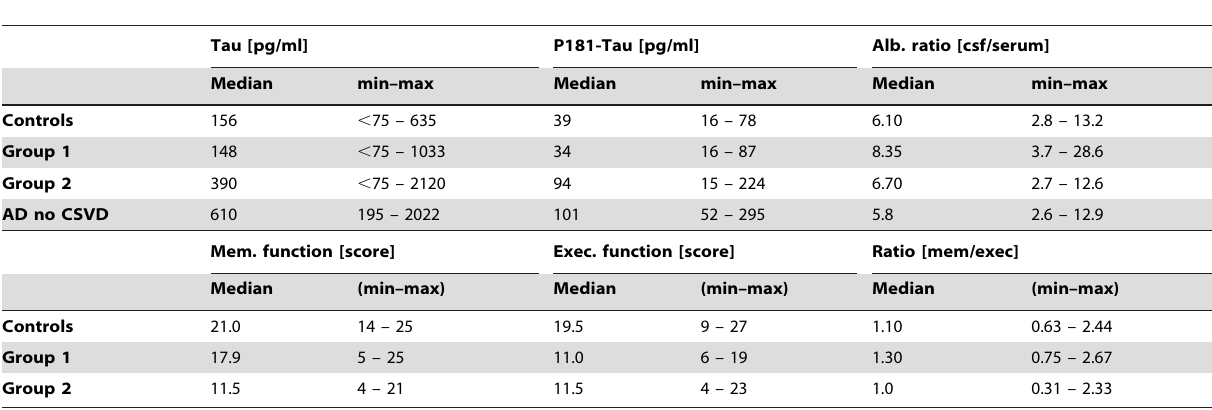
Table 2. Description of CSF biomarker and CAMCOG in